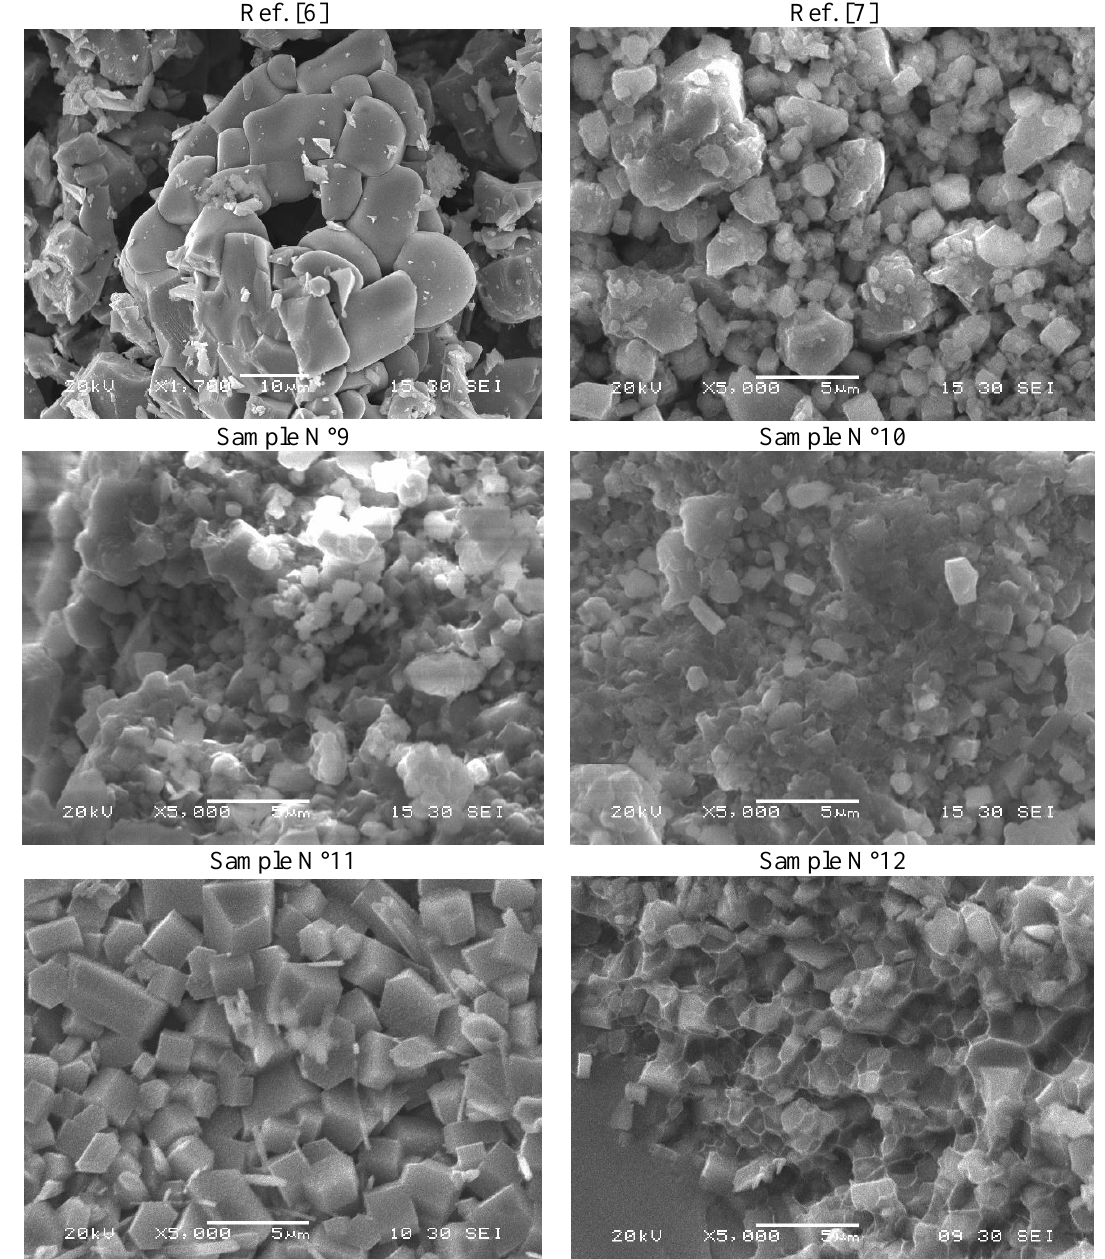
Figure 4. SEM microstructures of master alloys produced with